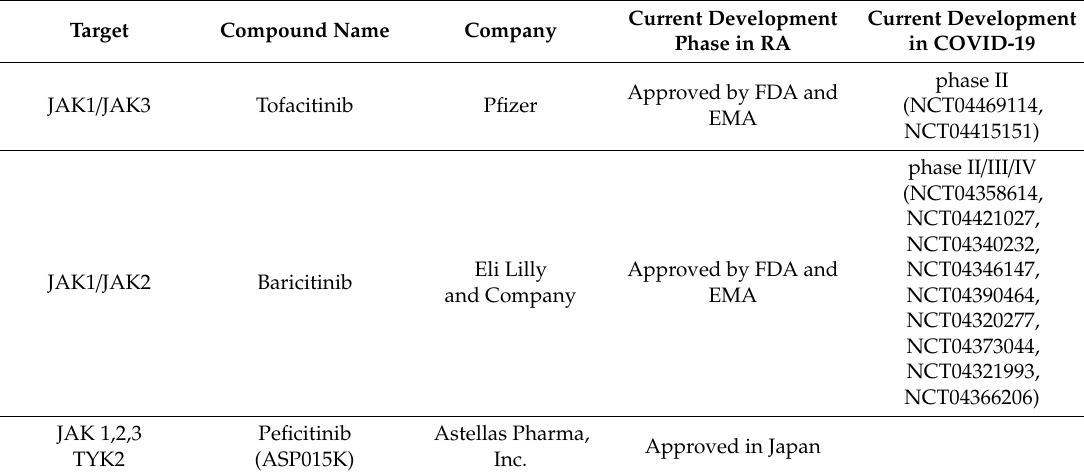
Table 1. Kinase and other small molecule inhibitors investigated in